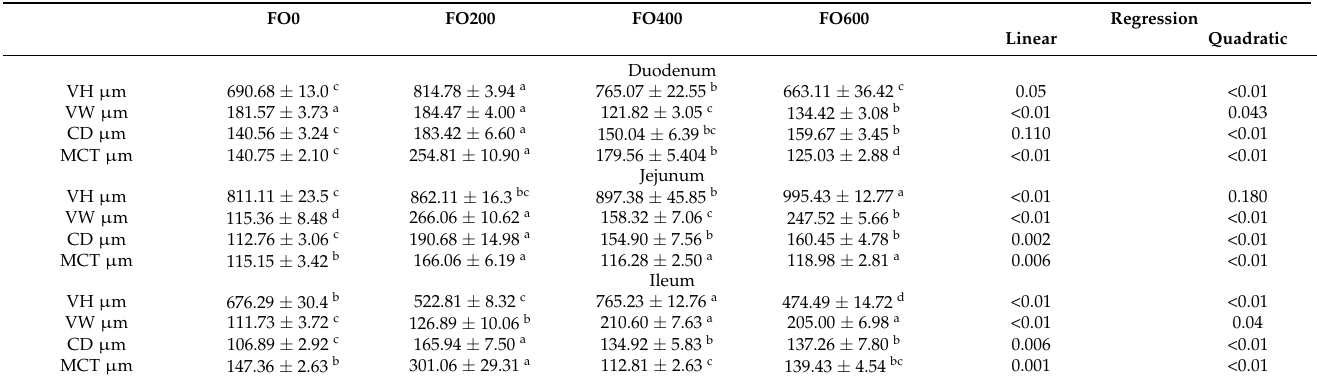
Table 6. Effect of Dietary FO Supplementation on Intestinal